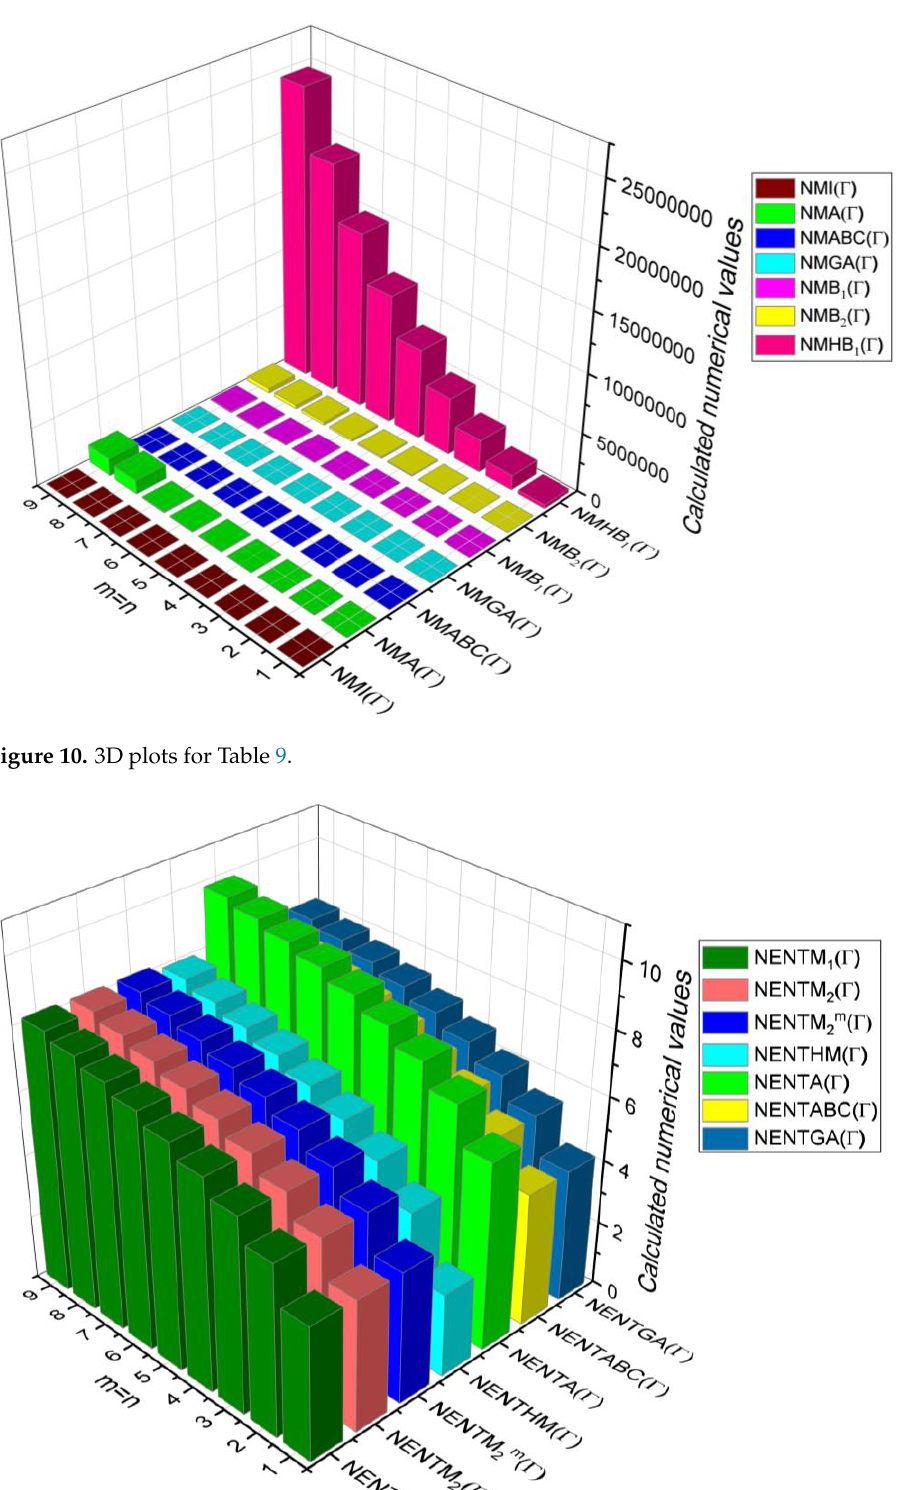
Table 9. Comparison Table for Theorem 5.